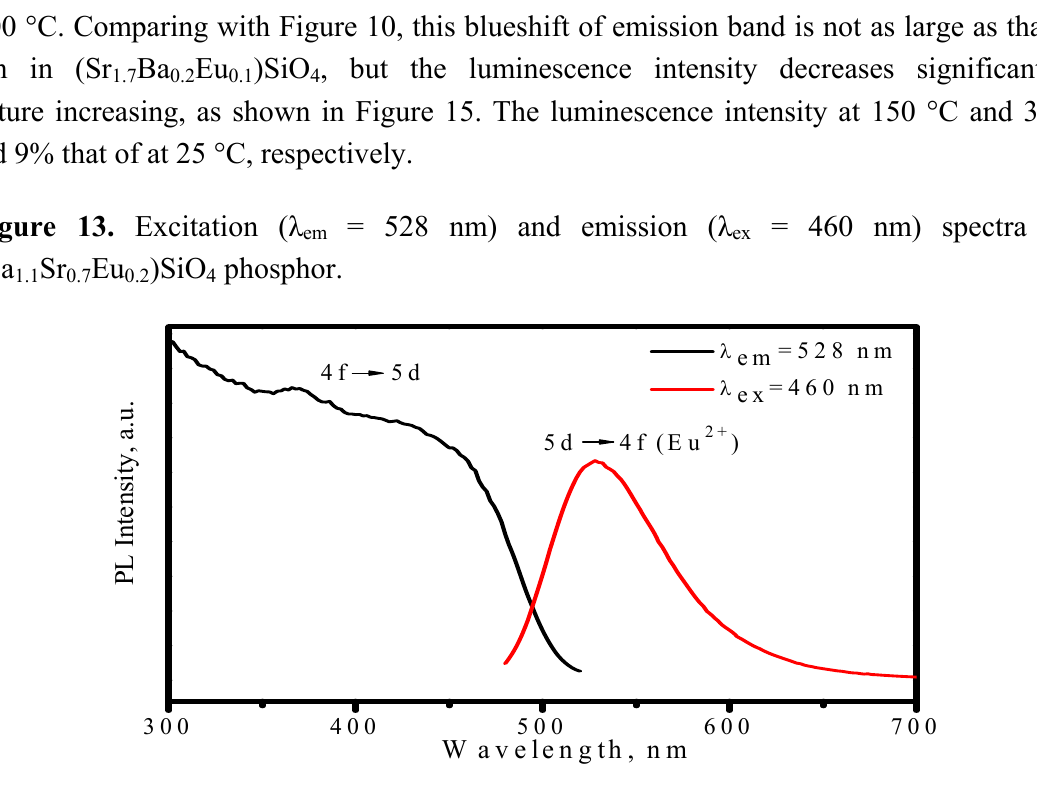
Sr Eu )SiO under 460 nm excitation measured at 1.1 0.7 0.2 4